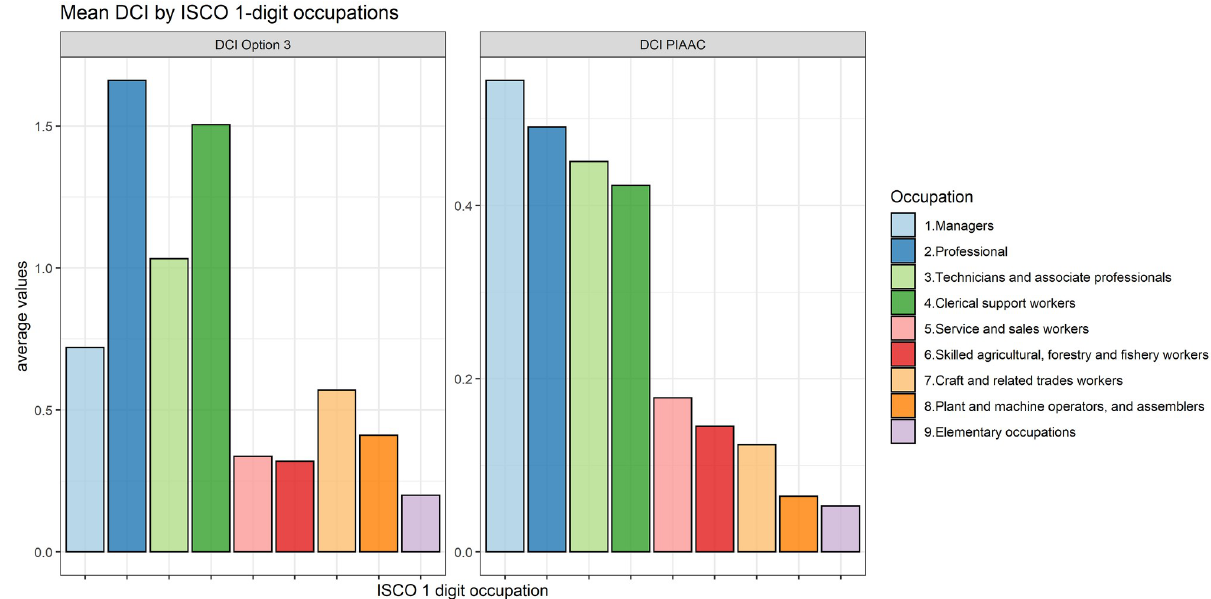
Fig 6. Mean values of DCI by 1-digit ISCO-08 code. Note: the overall occupation means for the PIAAC indicator are based on country means, which are calculated using the final weights provided in PIAAC.